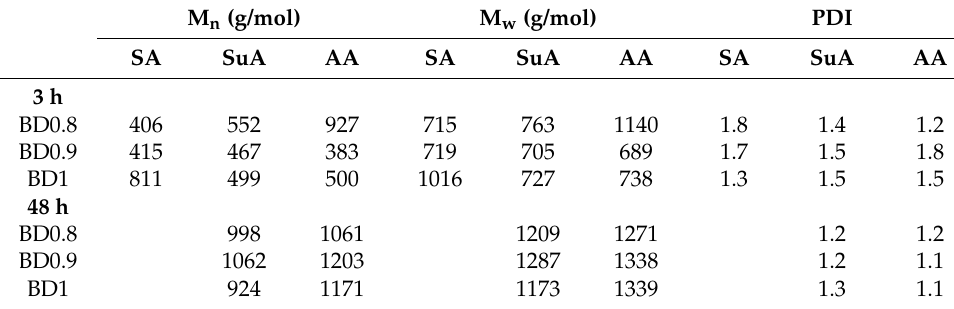
Figure 3. Positive ion ESI-MS of prepolymer BA0.8T at 1, 2, 3 and 38 h of polymerization. Table 2. Prepolymer M n , M w and PDI determined by ESI-MS at 3 h and 48h.